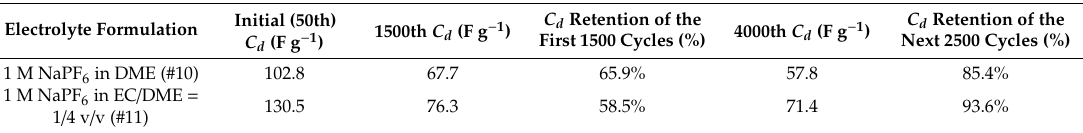
Table 6. Specific discharge capacitance retention of the KOH activated PC–MF electrode with electrolytes #10 and #11 after 4000 cycles. Electrolyte